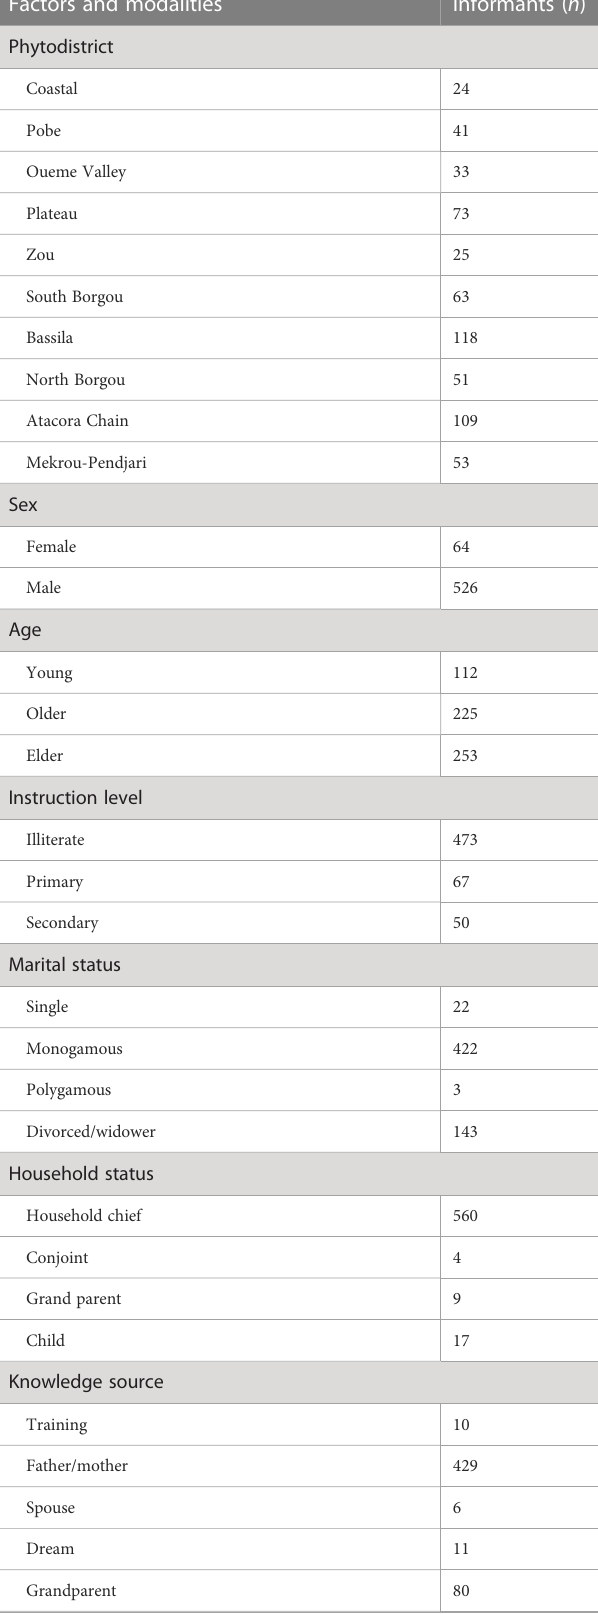
(Table 1) and EKI as a response variable. A fi rst conditional inference tree model was generated with the sociodemographic factors sex, age,